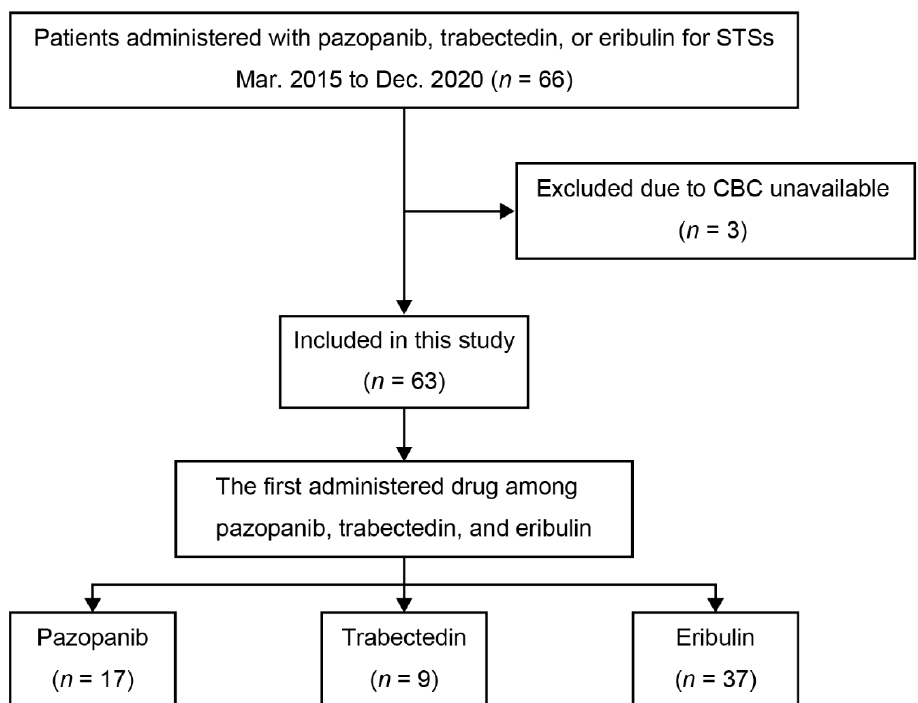
Figure 1. Flowchart of the study group selection process. STSs, soft tissue sarcomas. CBC, complete blood counts. The median OS for all patients was 602 days (95% confidence interval [95% CI] = 519–838) (Figure 2a). The choice of the first administered drug did not significantly influence OS (median: 744 days [95% CI = 519–1198] for eribulin, 520 days [95% CI = 223–602] for pazopanib, and 838 days [95% CI = 56–not reached (NR)] for trabectedin; p = 0.14) (Figure 2b). Univariate analysis of all the included cases showed that low NLR (HR = 0.50; 95% CI = 0.26–0.96; p = 0.037) and low LMR (HR = 2.24; 95% CI = 1.17–4.31; p = 0.015) were factors associated with OS (Table 2). Table 2. Univariate analyses of the baseline factors for OS.